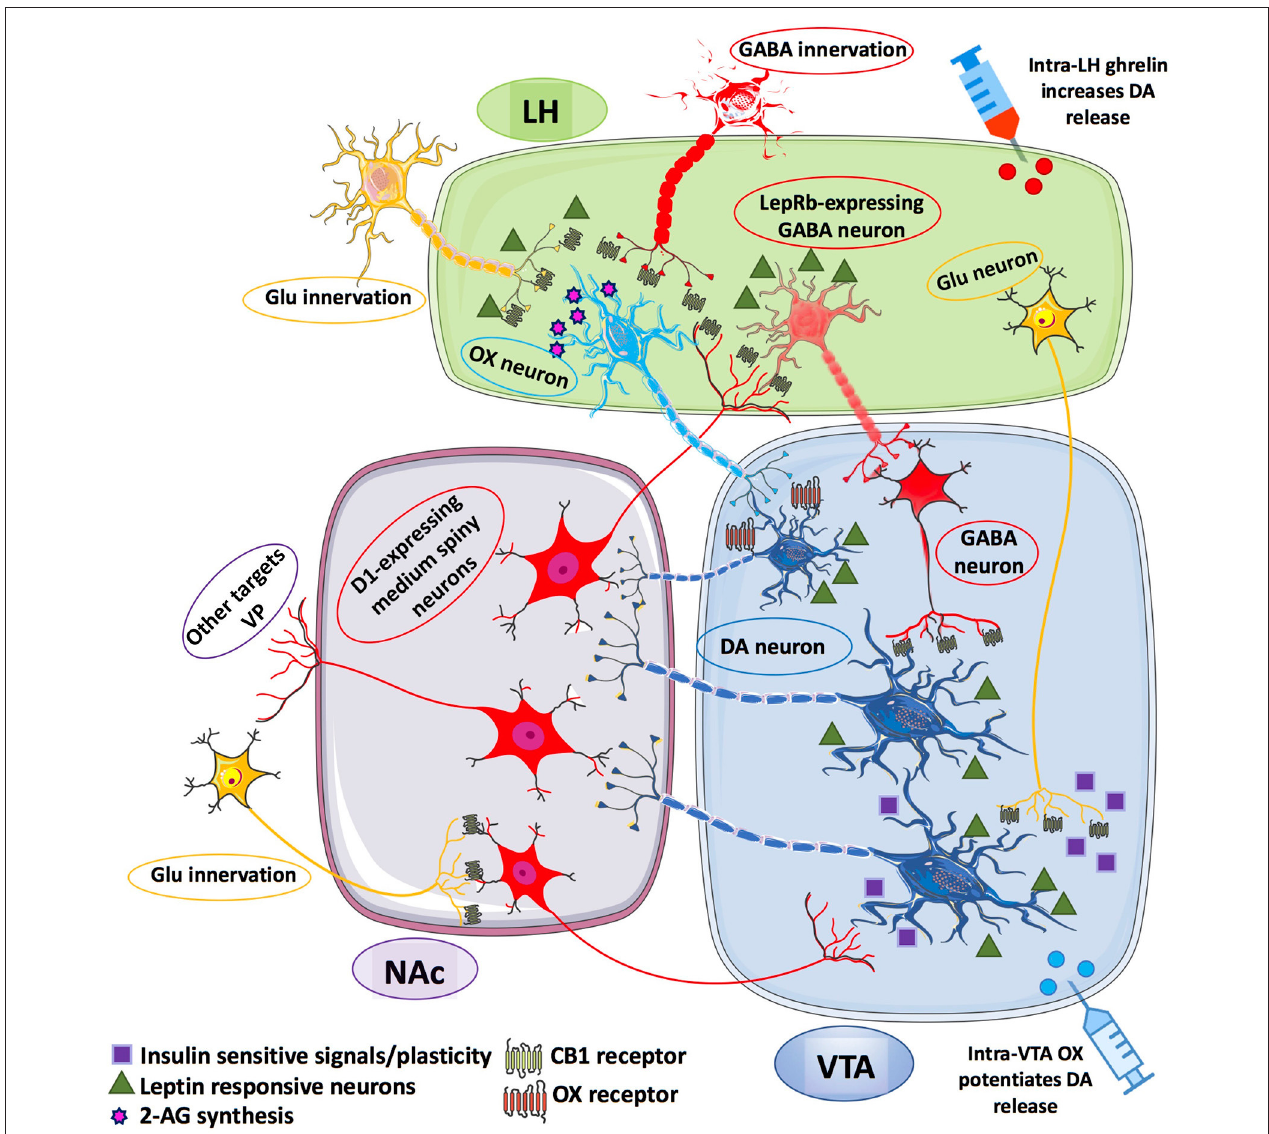
FIGURE 1 | Schematic representation of the information flow among the afferent and efferent neural pathways connecting lateral hypothalamus (LH), ventral tegmental area (VTA) and nucleus accumbens (NAc). LepRb-expressing GABA neurons within the LH receives inhibitory inputs from D1-expressing medium spiny neurons (MSNs) of the NAc. In turn, LH GABA neurons can inhibit VTA GABA-ergic neurons that disinhibit VTA DA neurons that may project onto D1-expressing MSNs of the NAc. LH OX neurons receives excitatory inputs from glutamatergic (Glu) innervation under the inhibitory control of presynaptic CB 1 receptors, also located on presynaptic GABA-ergic terminals that synapse OX neurons within the LH. OX neurons are thought to form local microcircuits by synapting VTA DA neurons establishing contacts with D1-expressing MSNs of the NAc, which project back to LepRb-expressing GABA neurons. Glu-ergic innervation from LH to VTA DA neurons is also illustrated as relevant instance of insulin- and leptin-sensitive information processing within the LH-mesolimbic DA circuit. The Glu-ergic pathway, along with presynaptic CB 1 receptors on Glu-ergic terminals contacting NAc MSNs illustrate an additional key component of the fine-tuned regulation of VTA DA neurons. Putative Glu-ergic neurons (yellow), GABA-ergic neurons (red), OX neurons (light blue) and DA-ergic neurons